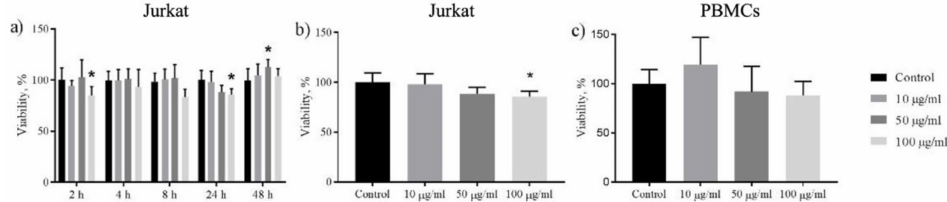
Figure 3. Viability of Jurkat cells: ( a ) after 2, 4, 8, 24 and 48 h treatment with 10, 50, and 100 µ g/mL suspension of Au/CFO; ( b ) after 24 h treatment with 10, 50, and 100 µ g/mL suspension of Au/CFO; ( c ) viability of PBMCs after 24 h treatment with 10, 50, and 100 µ g/mL suspension of Au/CFO. Cell viability was tested by WST-1 assay. All results are normalized by control and columns denoted by asterisks indicate results that were statistically different from the control (* for p value < 0.0332). Control wells were with the absence of